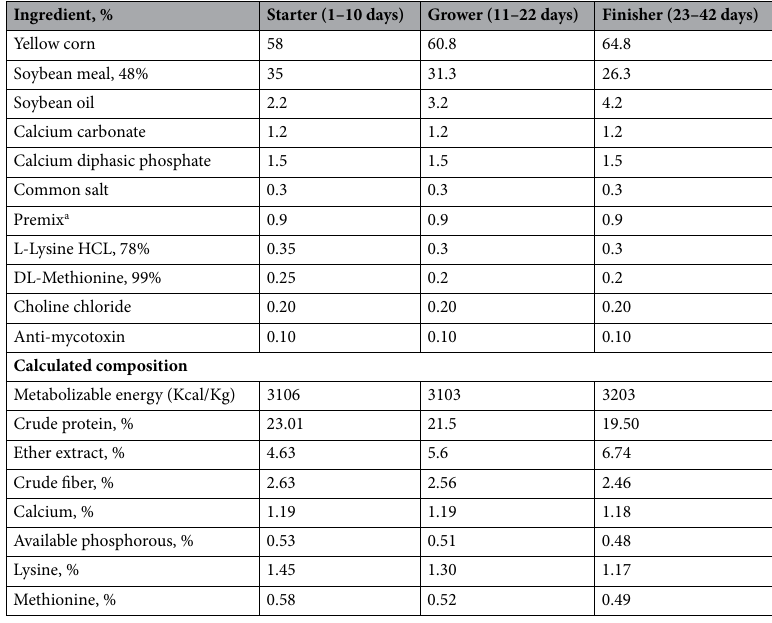
Table 2. The ingredients and nutrient content of basal diet. a Vitamin premix supplied per kilogram of diet: retinol, 10,000 IU; tocopheryl acetate, 70 mg, cholecalciferol, 6000 IU; menadione, 2.5 mg; riboflavin, 7 mg; thiamine, 4 mg; pantothenate, 12 mg; niacin, 50 mg; folate, 3 mg; pyridoxine, 6 mg; biotin, 300 μg; cyanocobalamine, 15 μg; Fe (sulphate), 30 mg; Cu (sulphate), 14 mg; Se (selenate), 0.3 mg; I (iodide), 1.20 mg; Zn (sulphate and oxide), 120 mg; Mn (sulphate and oxide), 100